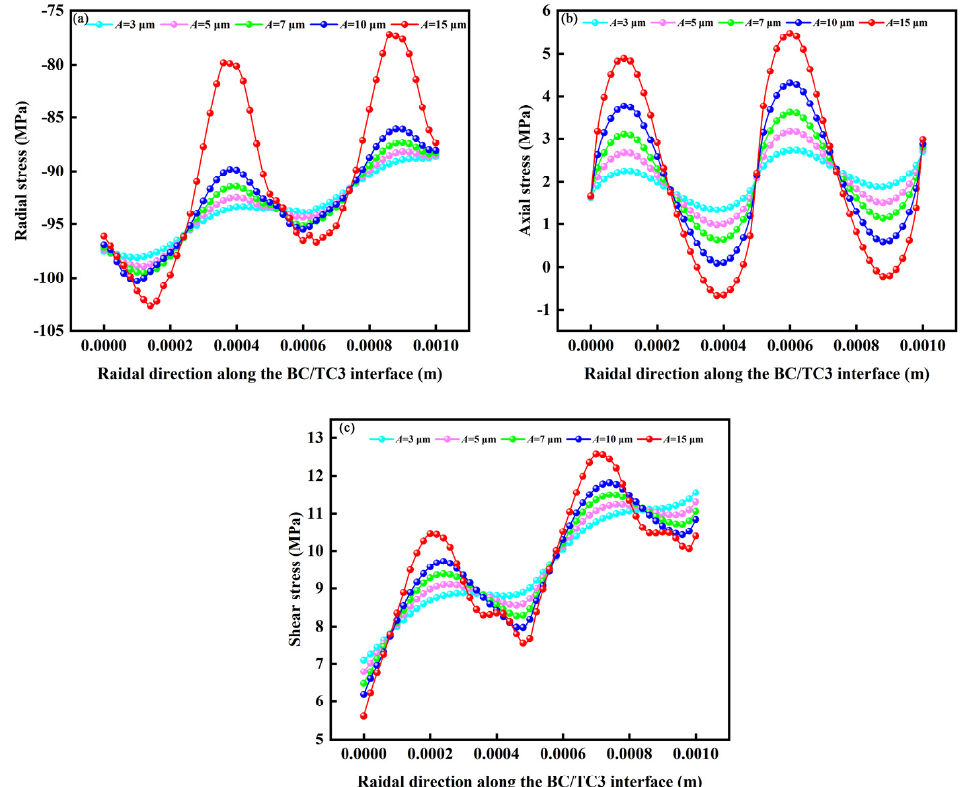
Figure 15. Stress distributions of BC/TC3 layer interface at different amplitudes: ( a ) radial stress; ( b ) axial stress and ( c ) shear stress.